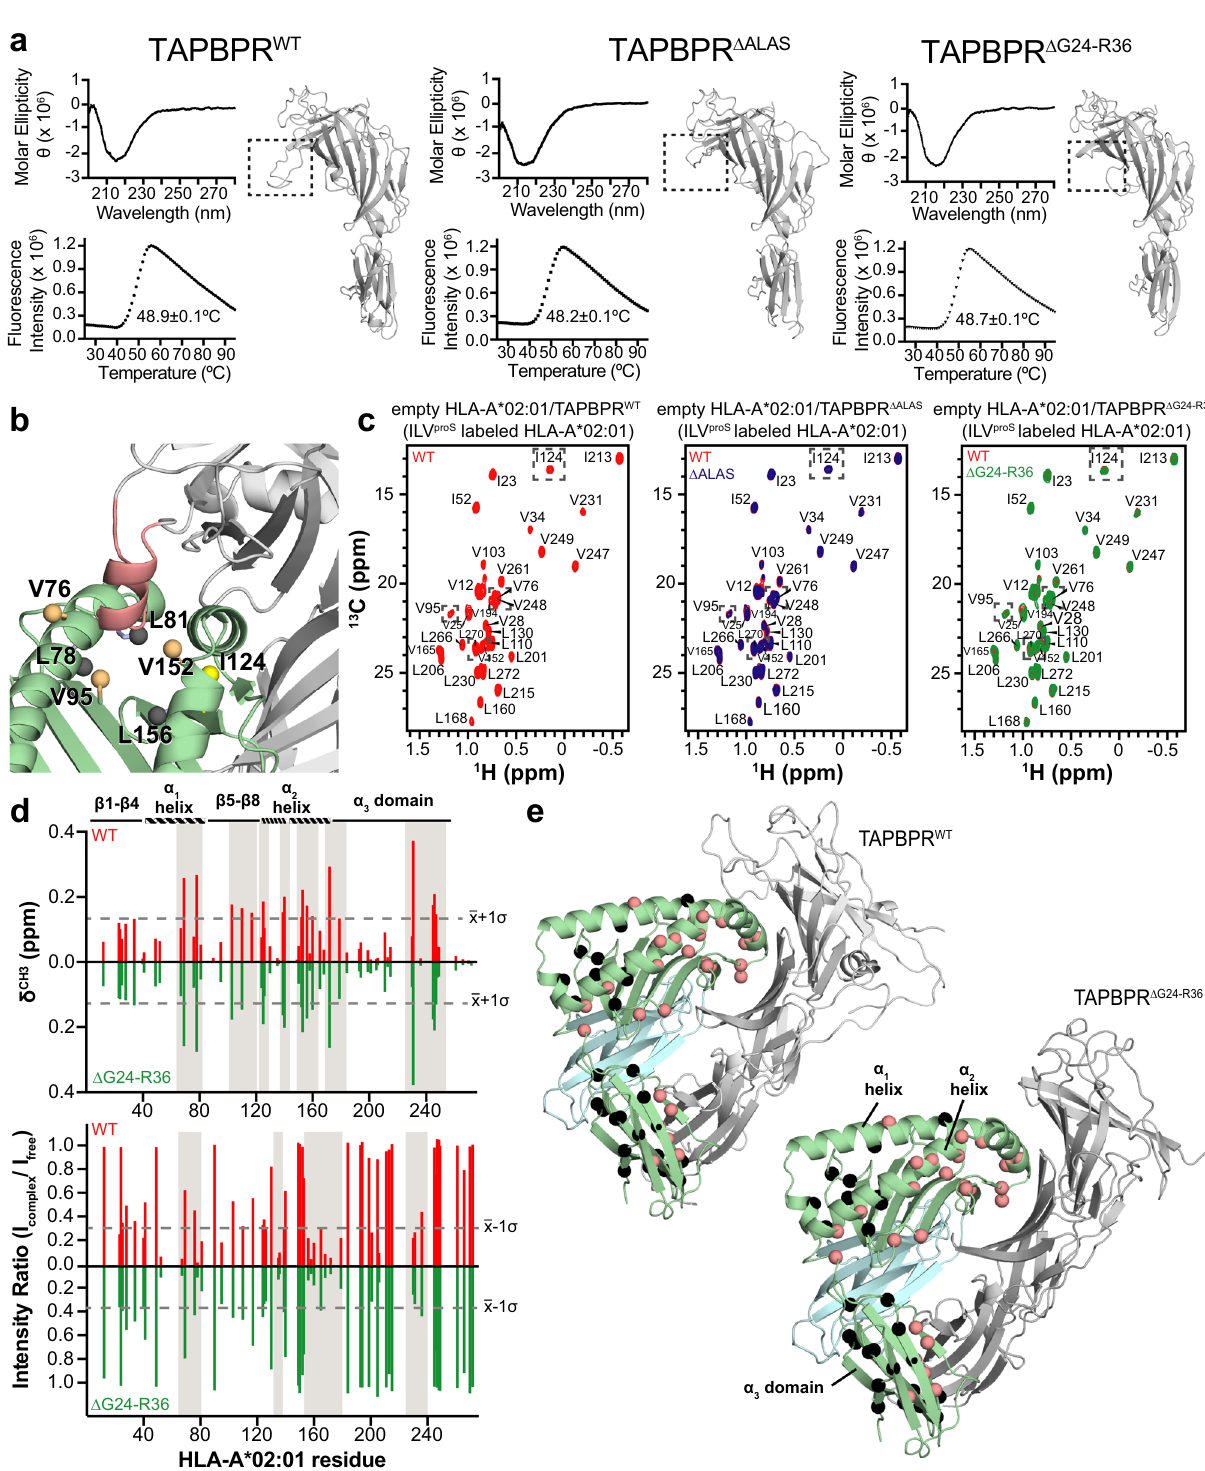
affected upon complex formation with TAPBPR are not in fl uenced by the removal of the TAPBPR G24-R36 loop (Fig. 4d). Mapping our NMR results on RosettaCM models of the HLA-A * 02:01/TAPBPR complex revealed a similar interaction surface as observed previously for other MHC-I/chaperone complexes by solution NMR, X-ray crystallography, and cryoEM 16 – 18,29 , suggesting that TAPBPR forms a stable complex with MHC-I molecules independently of the TAPBPR G24-R36 loop (Fig. 4e). We also examined chemical shift changes